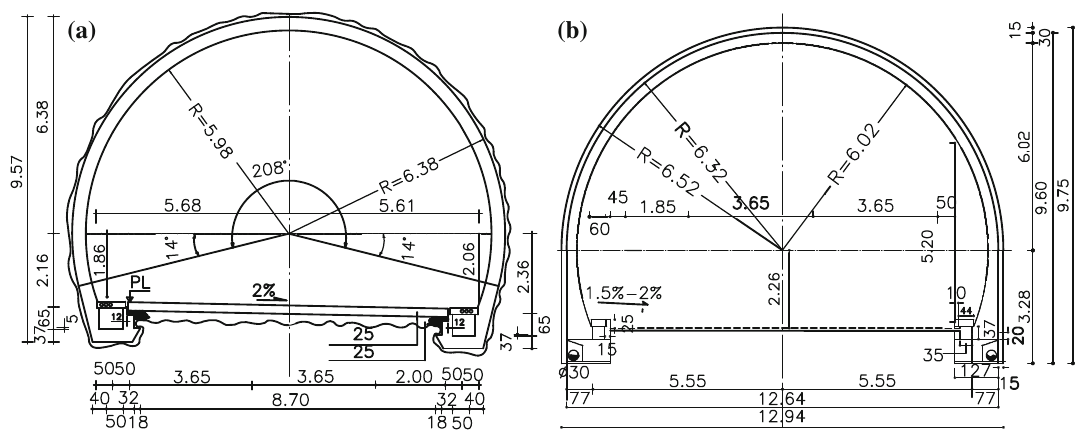
Fig. 3 Cross sections of Shibli tunnels ( a ) and Ilam-Mehran tunnel ( b ) (unit: